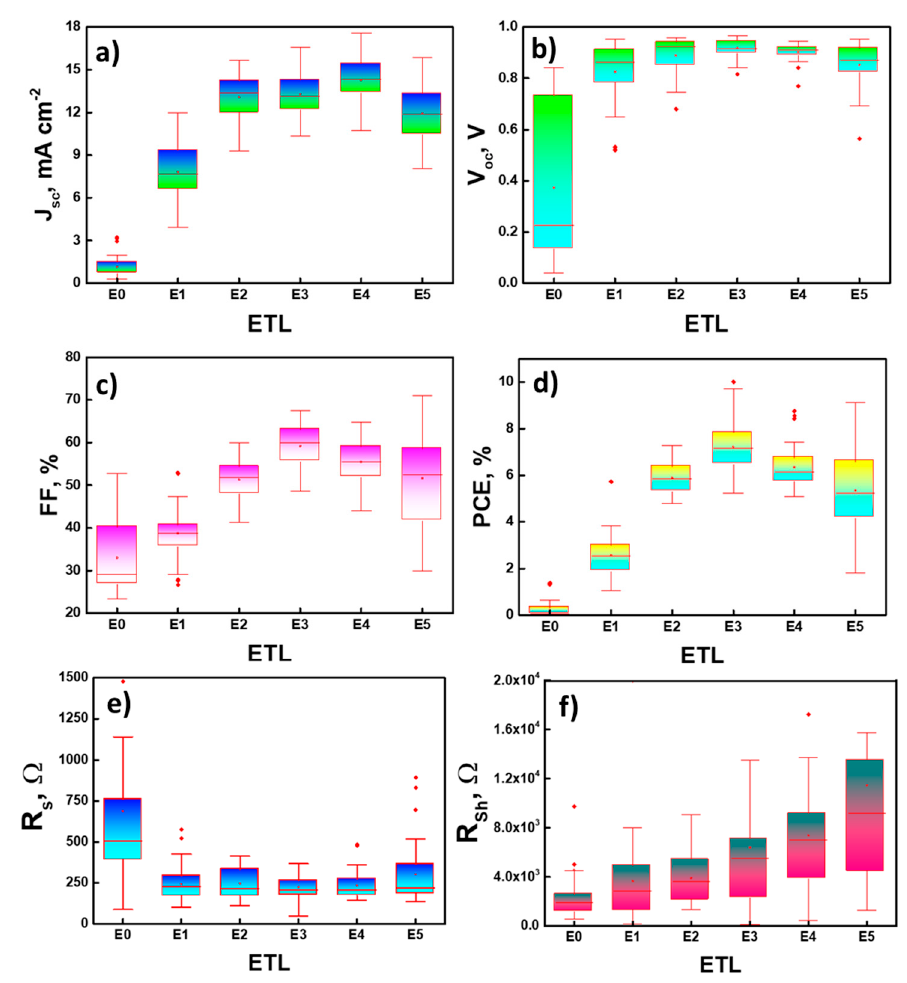
Figure 7. Comparison of the average values of ( a ) J sc , ( b ) V oc , ( c ) FF, ( d ) PCE, ( e ) R S , and ( f ) R Sh of printed and flexible PSCs for different SnO 2 ETLs prepared using SnO 2 QD inks with different QD concentrations. Table 1. Statistical analysis of the performance parameters of the top 40 well-performing devices for different ETLs.